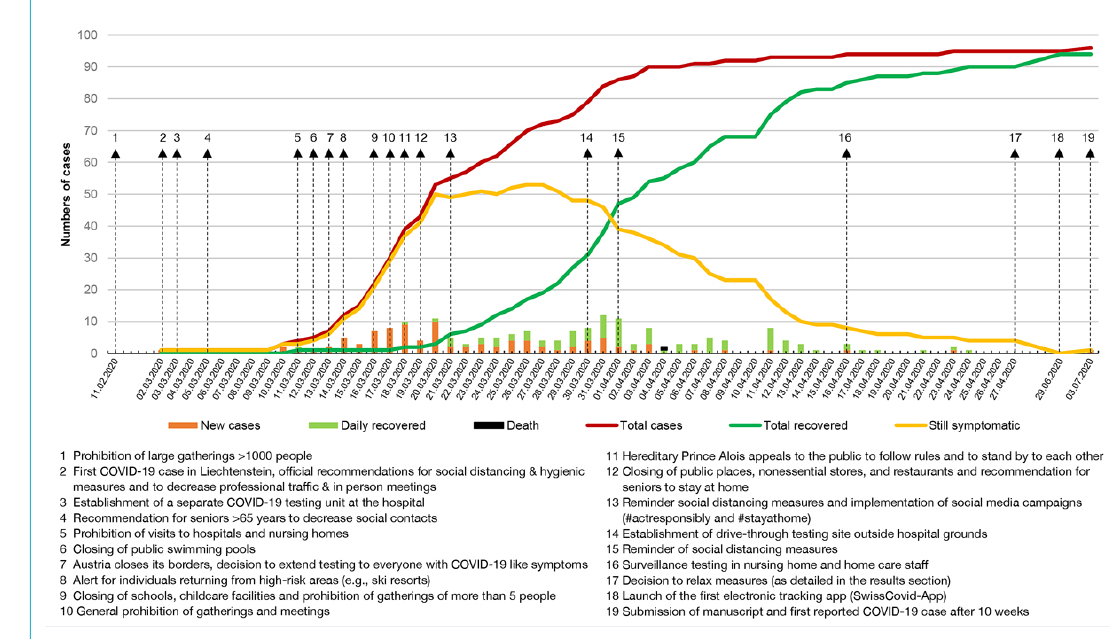
Figure 1: Timeline of PCR-confirmed COVID-19 cases in Liechtenstein with reference to public health measures taken during the first